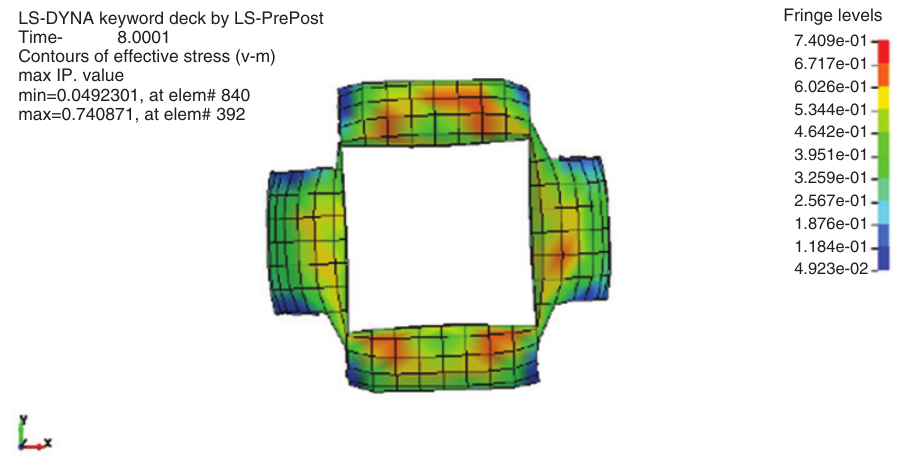
Figure 5 Contour plot of Von Mises stress of stacking sequence